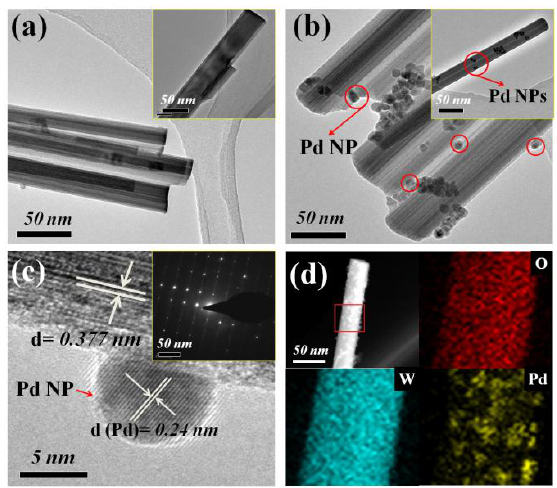
Figure 4. TEM images of ( a ) PS/WO 3 NRs (inset: single WO 3 NR); ( b ) PS/WO 3 –Pd60 (inset: